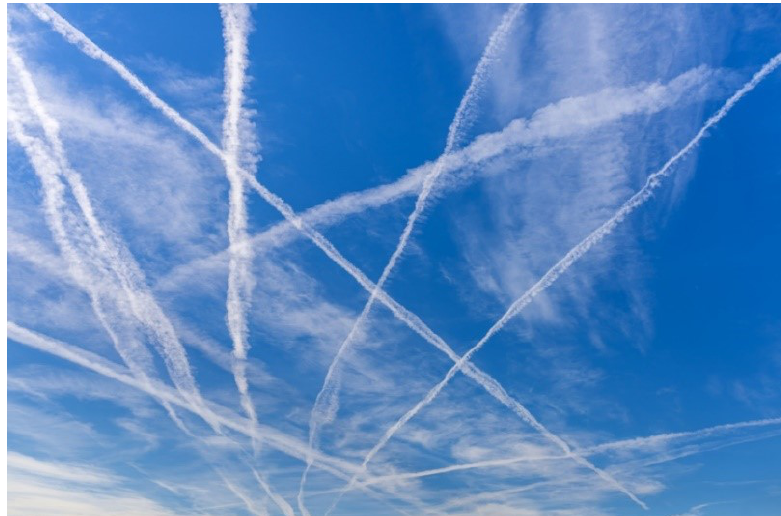
Figure 2. Example of contrails in the sky–forming mixture of structured and unstructured patterns